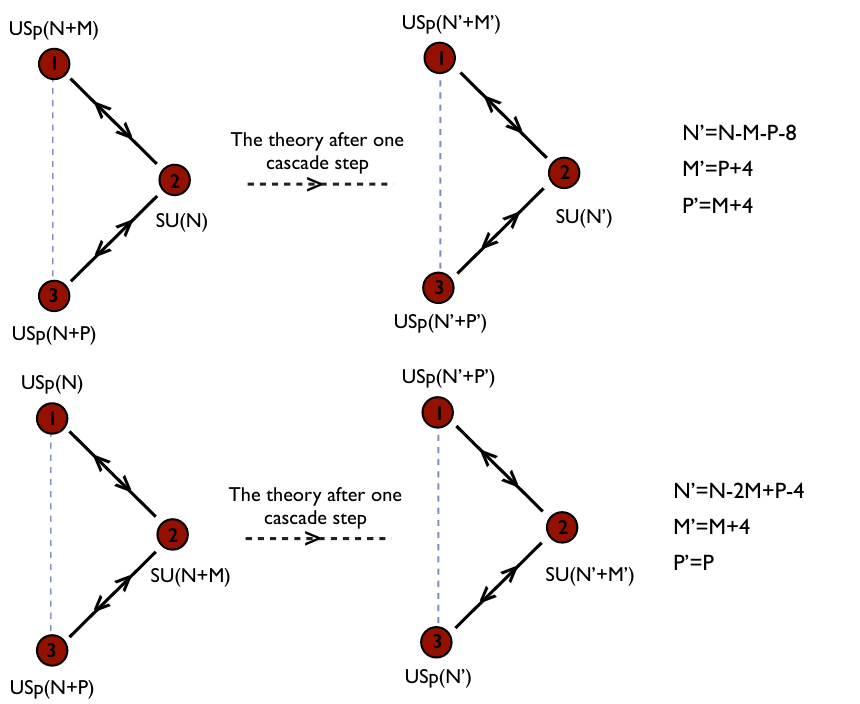
Figure 8 . The non-chiral orientifold quiver theories with two types of fractional branes and di(cid:11)erent rank assignments. Quivers on the right represent the theories after the (cid:12)rst cascade